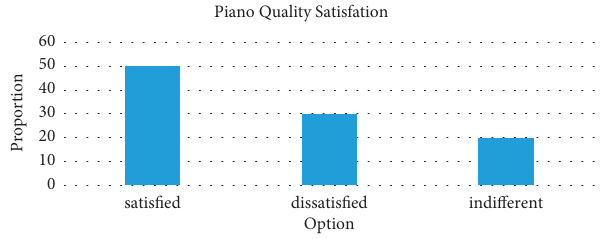
Figure 8: Students’ satisfaction with piano quality. Table 1: Weekly practice time of students after improvement. Option